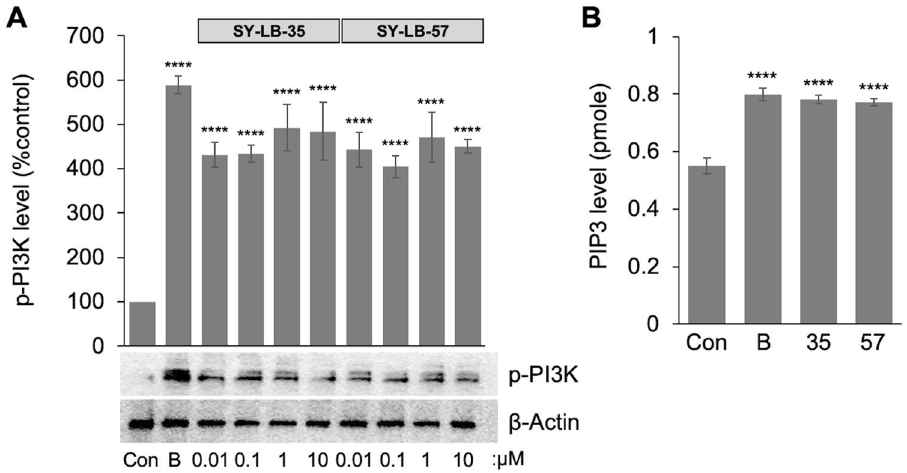
Figure 7. SY-LB-35 and SY-LB-57 stimulate the phosphorylation and activation of PI3K. (A) Western Blot analysis using anti-p-PI3K and anti-β-actin antibodies was performed on whole cell lysates of C2C12 cells treated with 50 ng/mL BMP2 as positive control, SY-LB-35 (0.01–10 µM) or SY-LB-57 (0.01–10 µM) for 15 min. Quantification of p-PI3K levels with respect to control, untreated C2C12 cells demonstrates that BMP2 (589%, **** p < 0.0005), SY-LB-35 (0.01 µM: 431%, 0.1 µM: 434%, 1 µM: 492%, 10 µM: 484%, **** p < 0.0005) and SY-LB- 57 (0.01 µM: 443%, 0.1 µM: 404%, 1 µM: 471%, 10 µM: 451%, **** p < 0.0005) caused significant increases in p-PI3K levels after 15 min. Levels of p-PI3K were normalized to β-actin levels and are expressed as a percent of control (mean ± SEM; n = 3). The original, uncropped blots are presented in Supplemental Figure S6. ( B ) Serum-starved C2C12 cells were stimulated with SY-LB-35 and SY-LB-57 at 10 µM for 15 min. BMP2 (50 ng/ mL) was used as a positive control. Whole cell lysates were prepared and PI3K was immunoprecipitated from the samples and PI3K activity was assessed using a PI3K ELISA. The amount of the product, PIP 3 , produced by PI3K enzyme was significantly higher in BMP2- (0.79 pmol), SY-LB-35- (0.77 pmol) and SY-LB-57-treated samples (0.77 pmol) compared to control (0.61 pmol; **** p ˂ 0.0005, n = 3). The optical density of all samples was measured at 450 nm and the enzyme activity was expressed as the amount of product (PIP 3 level) generated in each sample by the PI3K per minute of reaction.